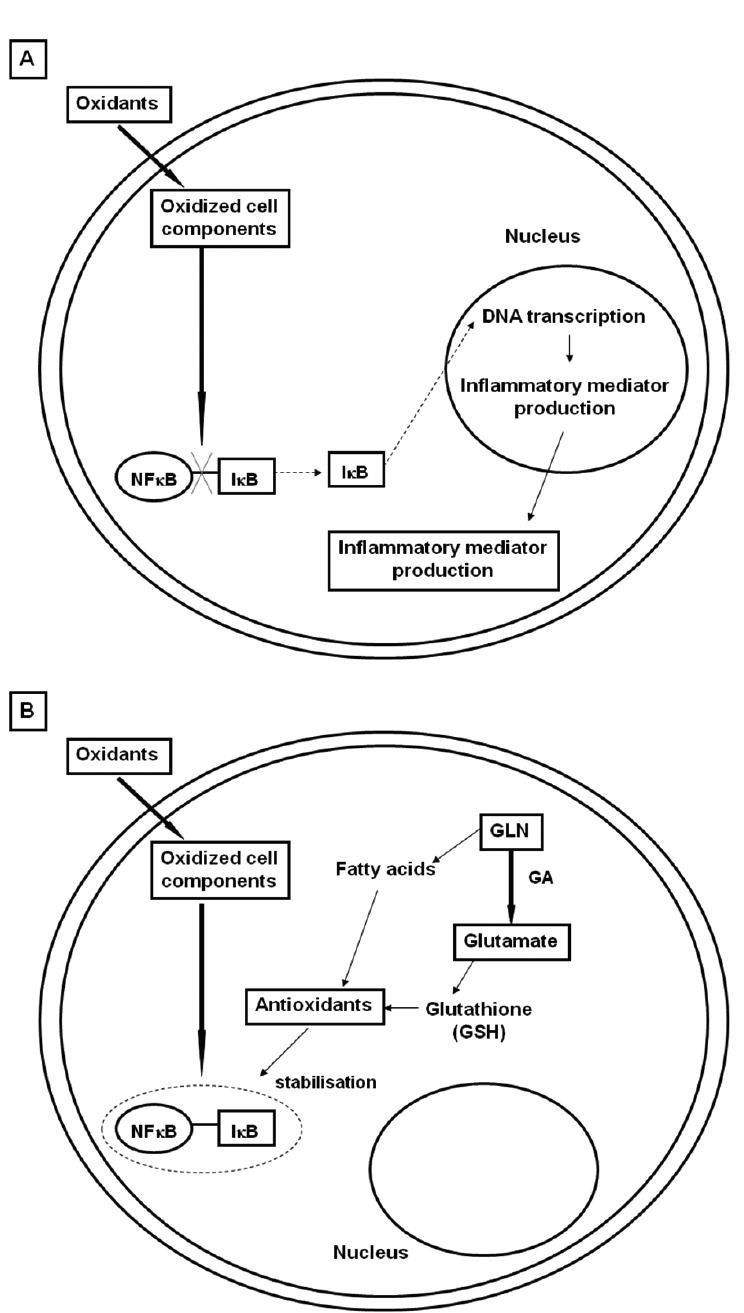
Fig. 2 – Nuclear factor (NF) κ B activation pathway. Panel A: NF- κ B is sequestered in the cytoplasm by its interaction with a member of the inhibitory kappa B (I κ B) family. After an injurious stimuli, I κ B- α is phosphorylated and degraded. Thus, NF- κ B is transported to the cell